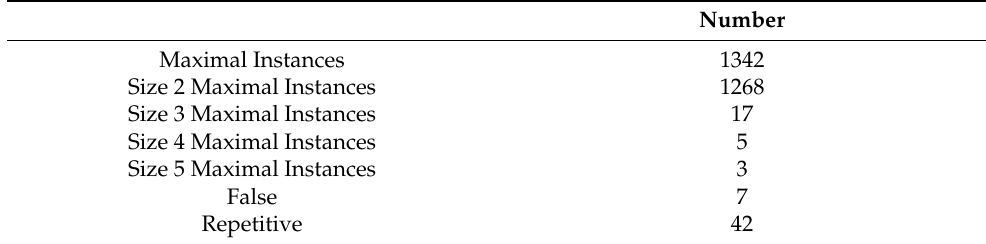
Table 4. The quality of maximum